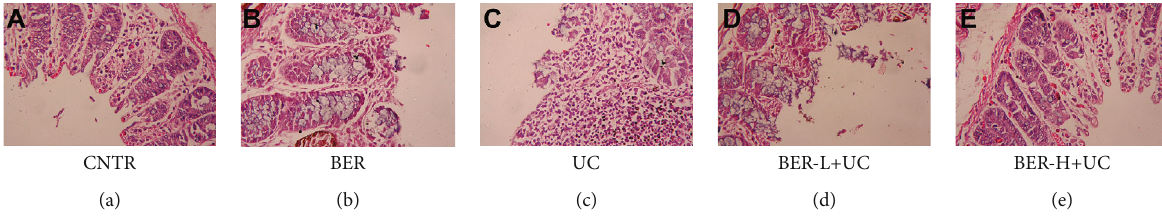
Figure 2: Histological fi ndings of the colon (H&E). (a) Colon from the CNTR group (intact group). (b) Colon from the BER group (without ulceration rats). (c) Colon in experimental colitis, untreated group; tissue injury is characterized by severe mucosal damage with severe hemorrhage and in fi ltration of in fl ammatory cells. (d) Colon in BER low dose (25 mg/kg) and experimental colitis, treated group, showing reduced tissue injury. (e) Colon in BER high dose (50 mg/kg) and experimental colitis, treated group, showing the greatest reduction in the tissue injury characterized by less mucosal damage and low in fi ltration of in fl ammatory cells. All the images were taken at a 200x magni fi